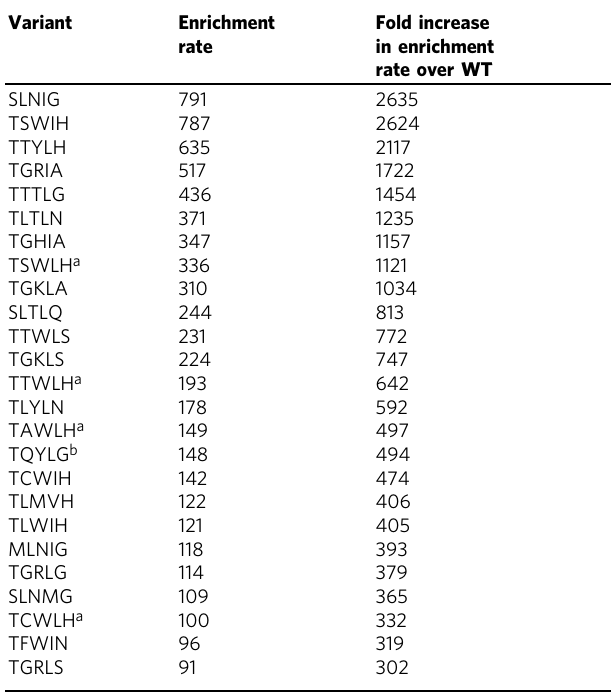
a Single-residue mutant, b Proximal double-residue